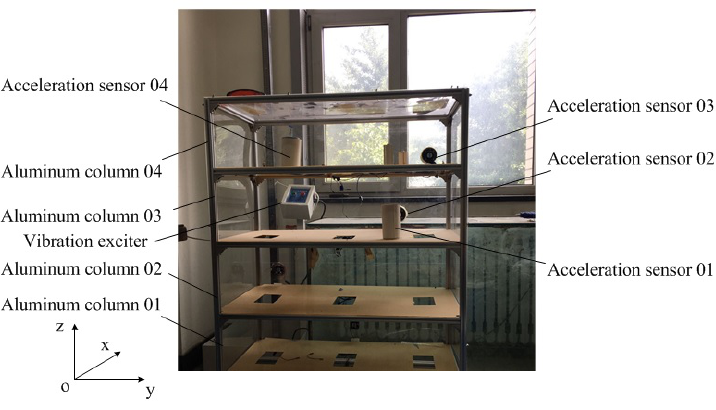
Figure 2. Frame structure and the sensor arrangement.